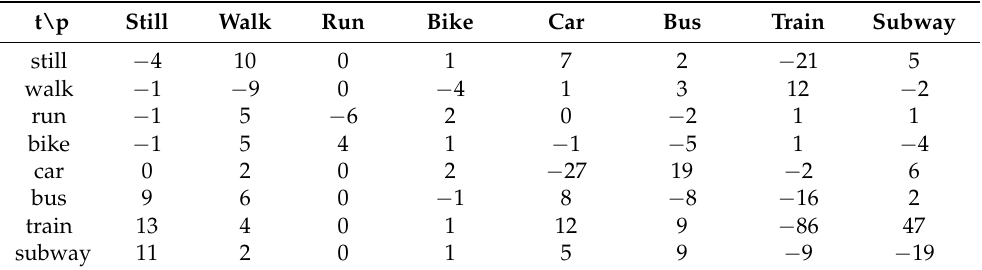
Table 5. The difference confusion matrix of the network trained without the gravity software sensor. The largest loss in classification occurred in the class subway and the smallest in class run . t = true label, p = predicted label.